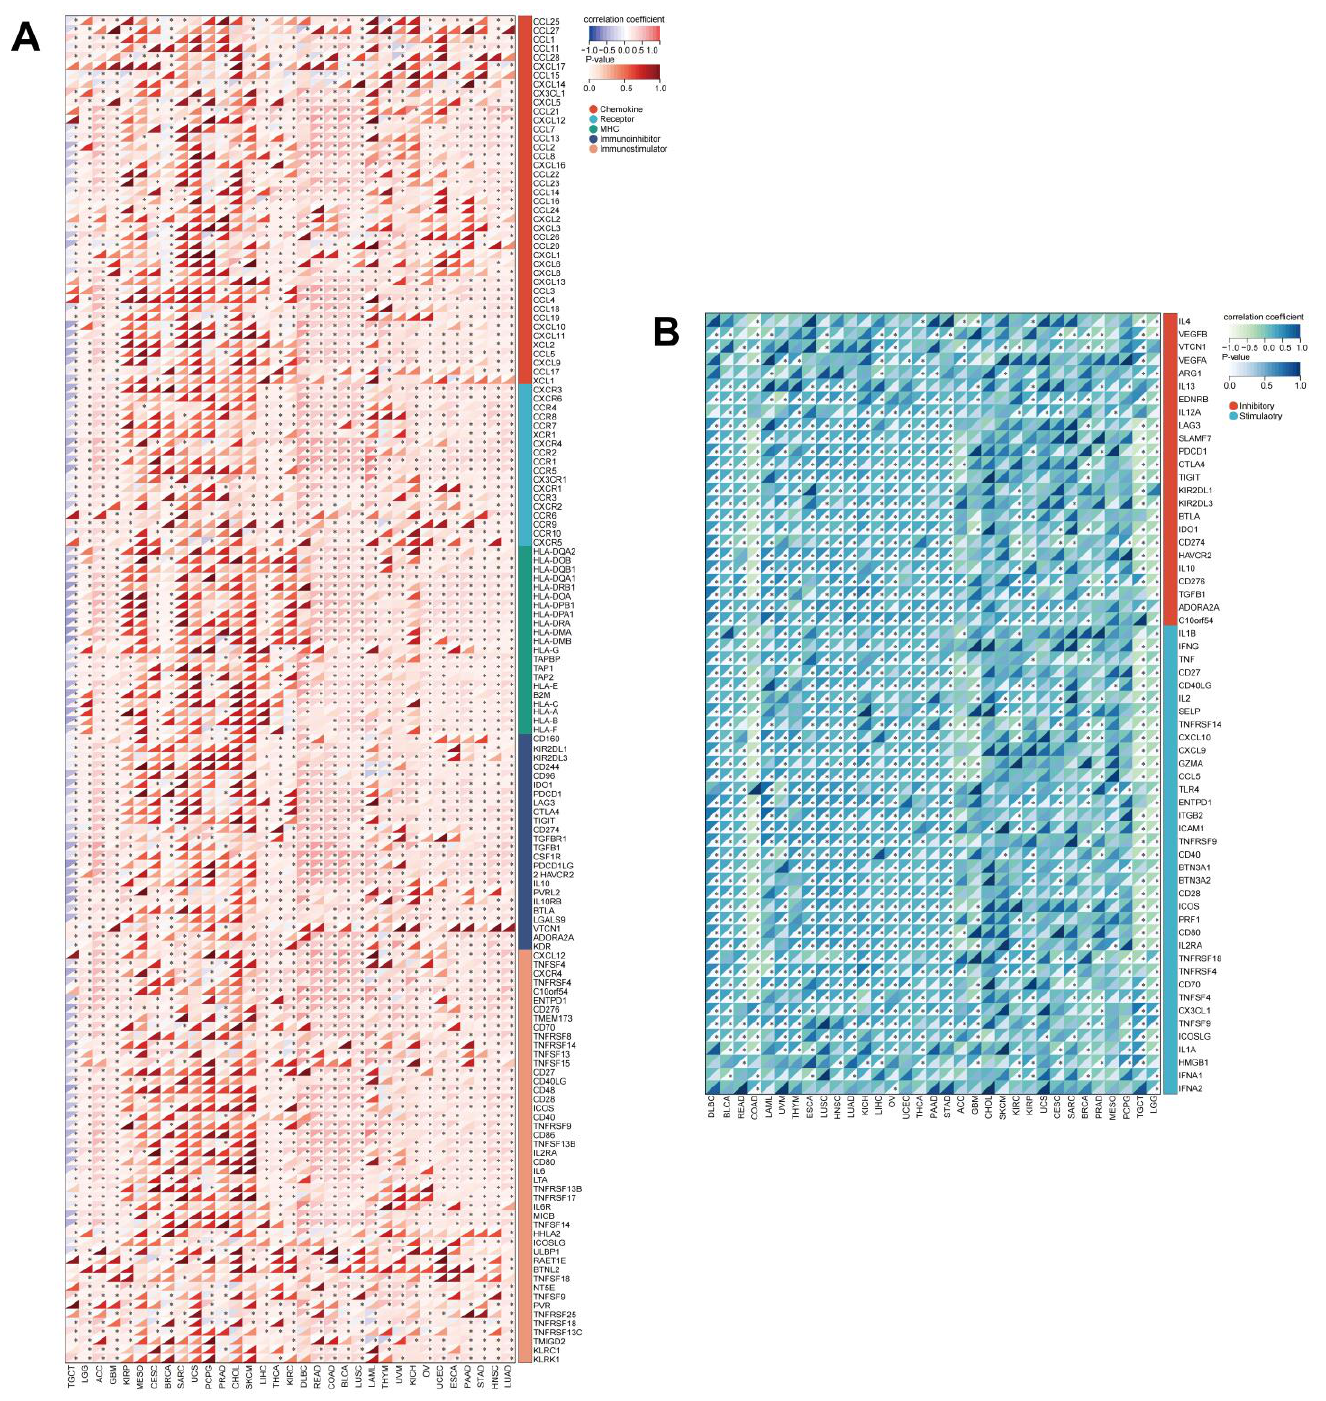
Figure 10. Correlations between UNC5A expression and tumor immunity. ( A ) The relationships between UNC5A expression and various immunomodulators in pan-cancer. ( B ) The relationships between UNC5A expression and various ICP genes in pan-cancer. * P < 0.05. 3.9. UNC5A Expression is Associated with DNA Methylation in Pan-cancer DNA methylation is crucial in tumor onset progression, as confirmed in numerous studies[30,31]. Thus, assessing the association of UNC5A level with the DNA methylation status in cancers is of great significance. First, we evaluated the association of the four DNA methyltransferases with UNC5A expression in pan-cancer and observed that